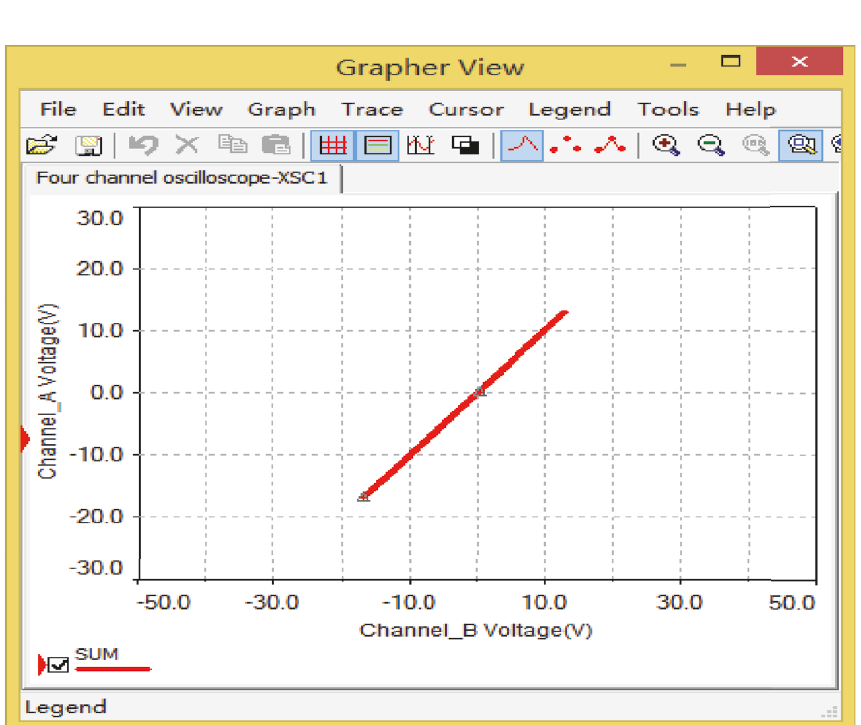
Figure 18: Synchronous phase portrait of